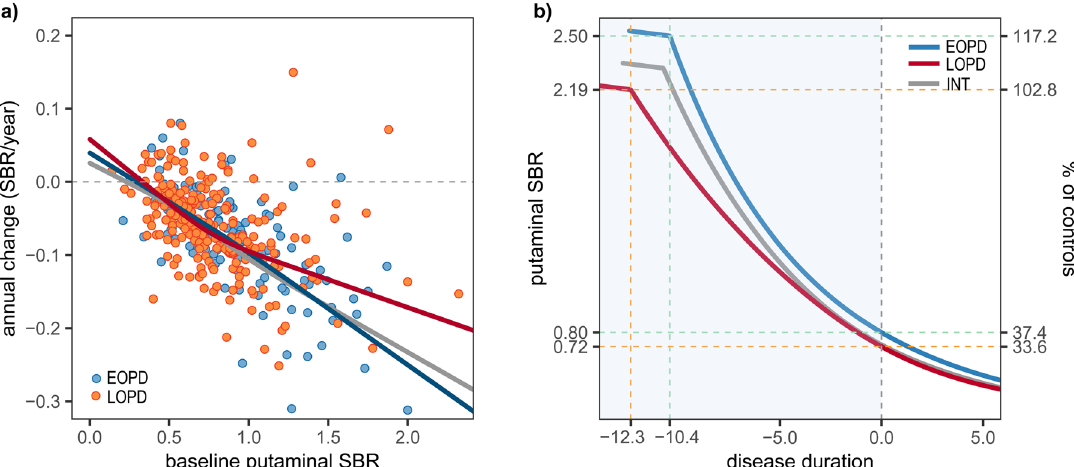
Fig. 3 Comparison of annual change rates against baseline SBRs and DAT trajectories between EOPD, intermediate-onset, and LOPD groups in the PPMI cohort. a sPD patients with early and intermediate onset showed similar curves, but annual change rates in EOPD patients are lower within the range over 0.9 of the baseline SBR compared to the LOPD group. Outliers beyond the fi rst or third quartile ± 3 × interquartile range were not shown (2 putamen, sPD group of PPMI cohort). All outliers were included in the calculation of temporal trajectories. b Estimated trajectory of the intermediate-onset group was close to EOPD group, however, EOPD patients show a shorter premotor phase and faster DAT decline during the premotor period than the LOPD group (B; INT = intermediate